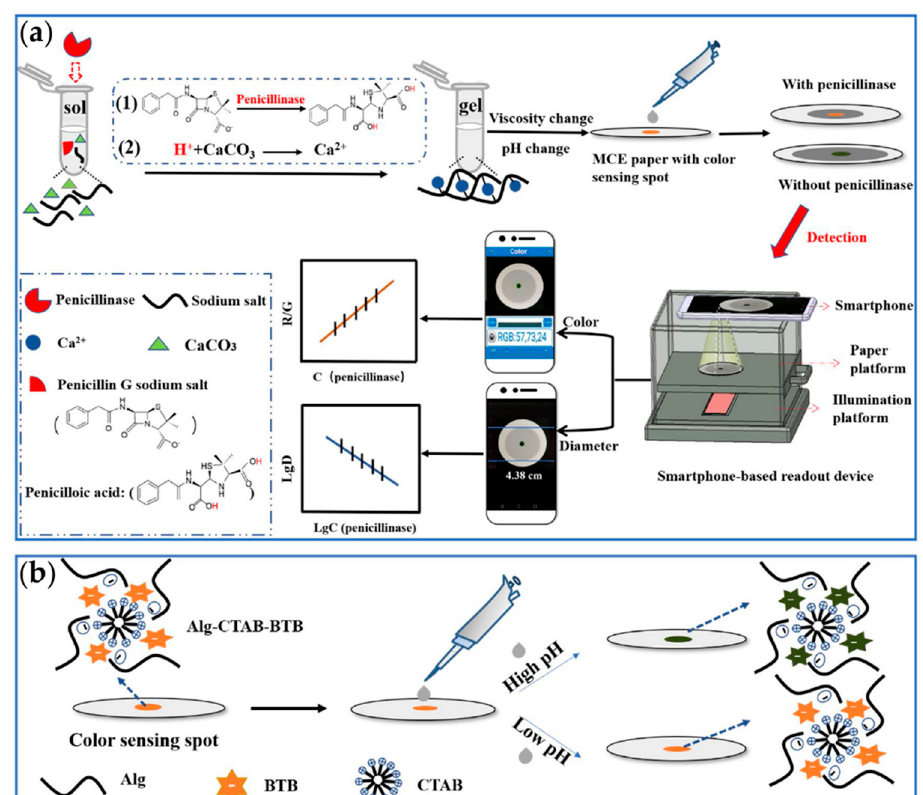
Figure 11. Schematic illustration of the dual-readout paper-based sensor using pH-responsive hydrogels for the detection of penicillinase and its discoloration principle. ( a ) The formation principle of the sensing materials, detection phenomena and the profile-view of the detection equipment are given; ( b ) The discoloration principle of the color sensing spots for the detection of pH. Reproduced with permission from JiaXu, Sensors and Actuators B: Chemical; published by Elsevier, 2021.